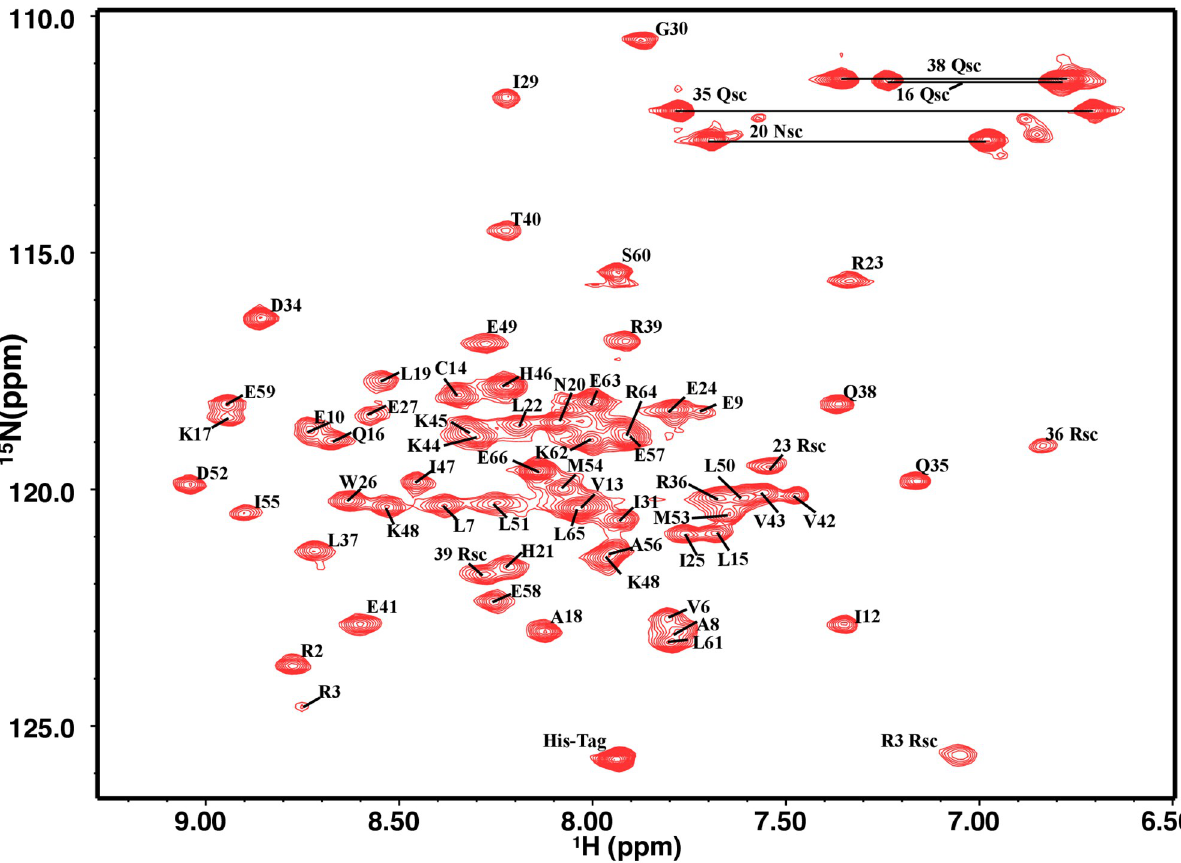
Fig 1. Two-dimensional 1 H - 15 N HSQC spectrum and assignment of